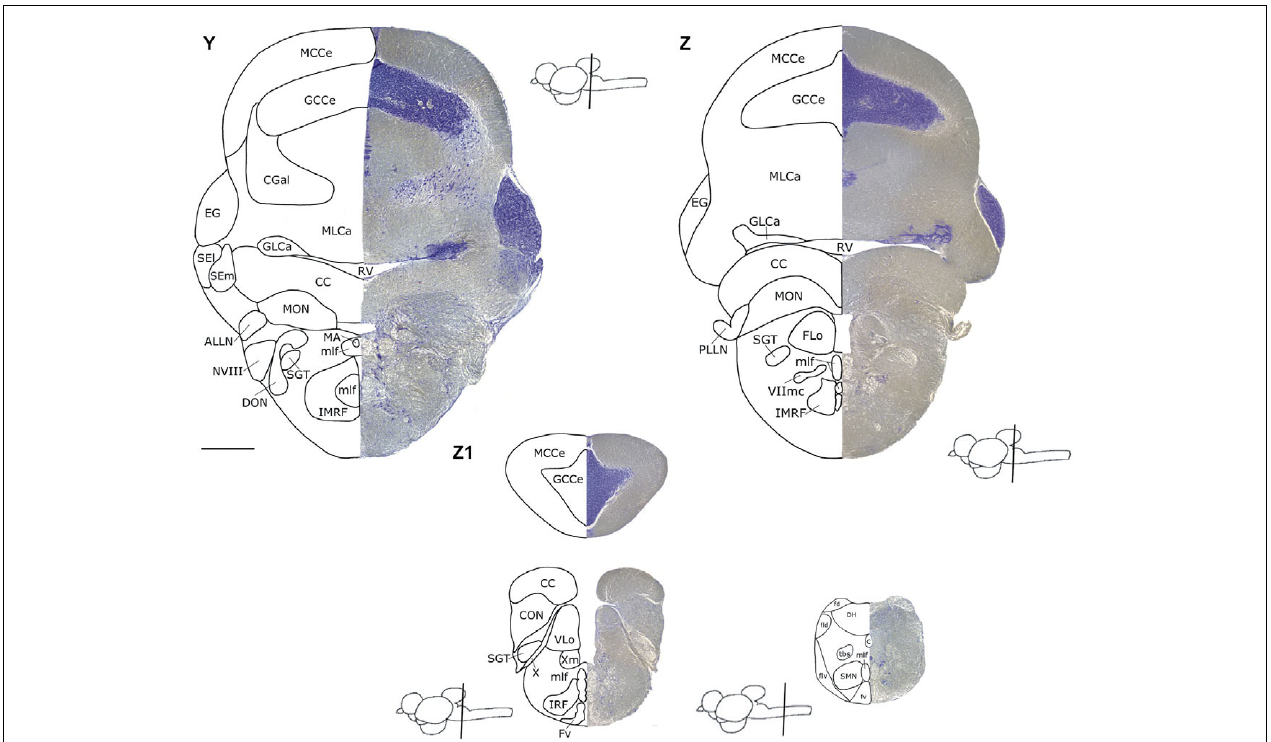
FIGURE 3 | An atlas of the brain of the archerfish Toxotes chatareus . Nissl-stained (creysl violet) transverse sections (shown on the right) from telencephalic (A–F) via diencephalic (G–L) , mesencephalic (G–W) to rhombencephalic (P–Z1) levels with corresponding schematic drawings (shown on the left). Scale bar for all panels: 0,5 mm. See abbreviation list and text for